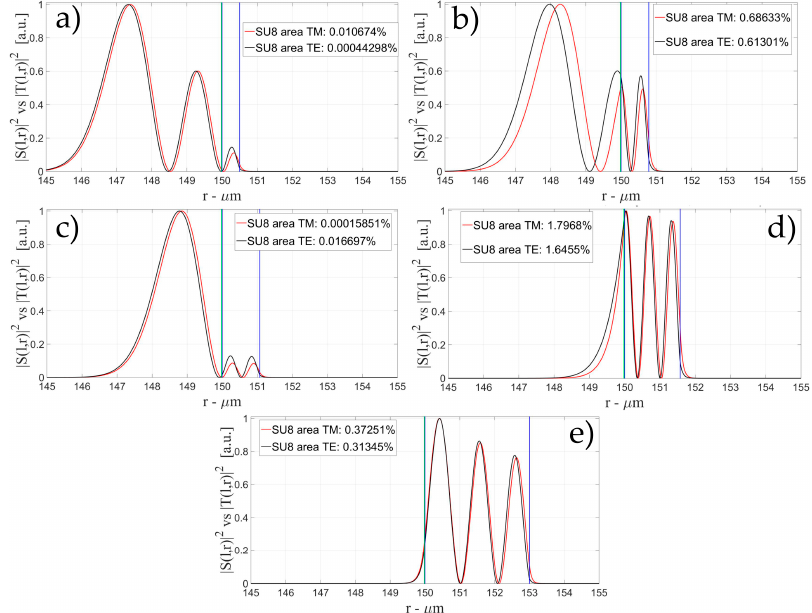
Figure 6. Electric field distribution of WGMs along the radial direction for TE (| S ( l,r ) | 2 ) and TM (| T ( l,r ) | 2 ) modes for the 2nd radial order and wall thickness: ( a ) for a wall of about 500 nm (minimum sensitivity); ( b ) for a wall of about 800 nm (maximum sensitivity); ( c ) for a wall of about 1 μ m (minimum sensitivity); ( d ) for a wall of about 1.6 μ m (maximum sensitivity); and ( e ) for a wall of about 3 μ m (minimum sensitivity). Legends show the fraction of | S ( l,r ) | 2 and | T ( l,r ) | 2 inside the biological layer.